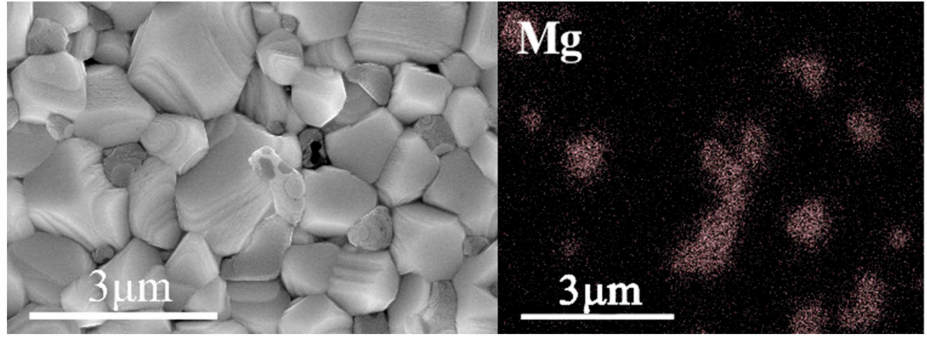
Figure 7. EDS maps of the BST-2 mol% MgO